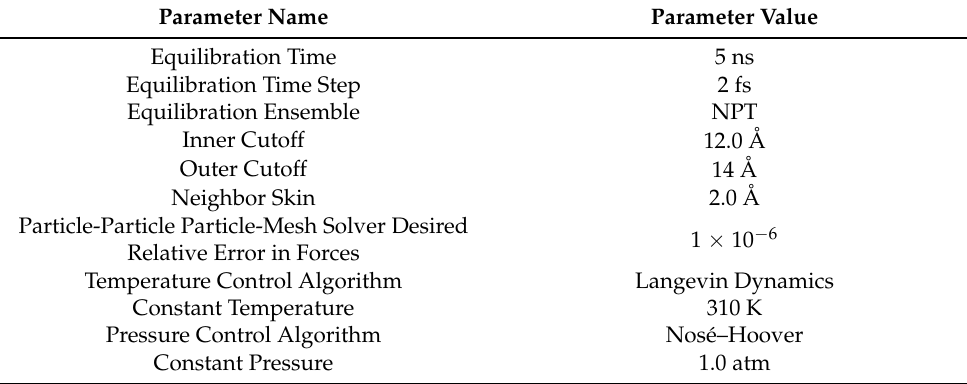
Table 3. Parameters of MD simulation for minimization and equilibration in LAMMPS. Parameter Name Parameter Value Equilibration Time 5 ns Equilibration Time Step 2 fs Equilibration Ensemble NPT Inner Cutoff 12.0 Å Outer Cutoff 14 Å Neighbor Skin 2.0 Å Particle-Particle Particle-Mesh Solver Desired 1 × 10 − 6 Relative Error in Forces Temperature Control